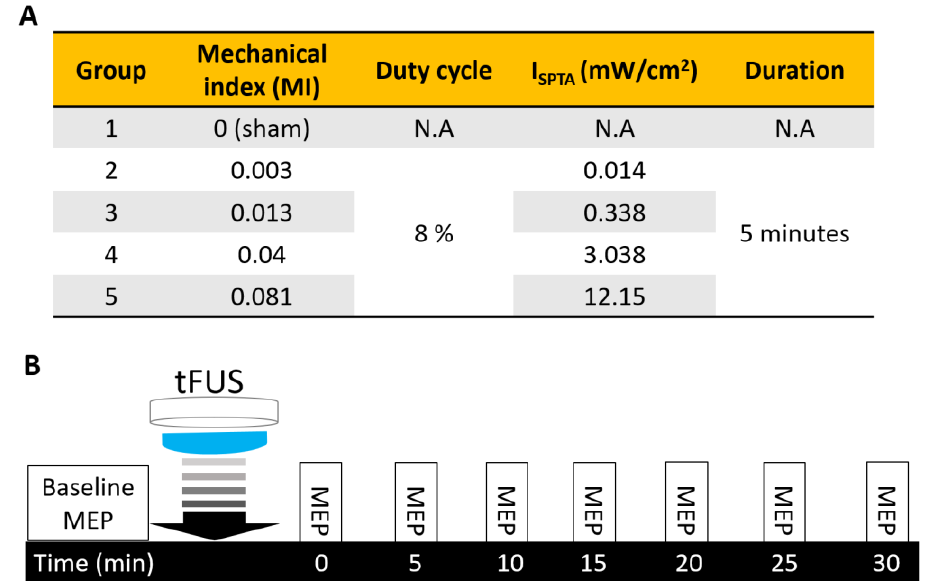
Figure 8. ( A ) Summary of tFUS parameters used in individual experimental groups. MI: Mechanical index; I SPTA = spatial-peak temporal averaged intensity. Duty cycle = percentage of time divided by the total time of a stimulus train. ( B ) Motor-evoked potential (MEP) recording and tFUS sonication protocol.